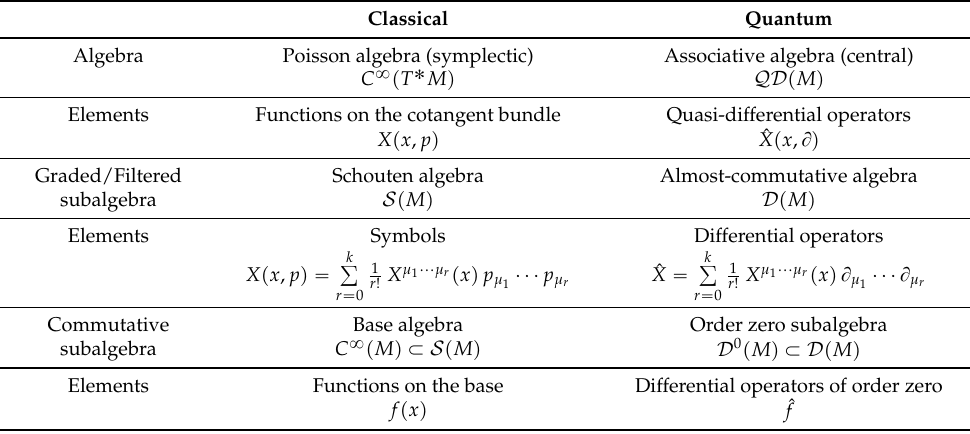
Table 2. Classical versus quantum algebras of functions on the cotangent bundle.